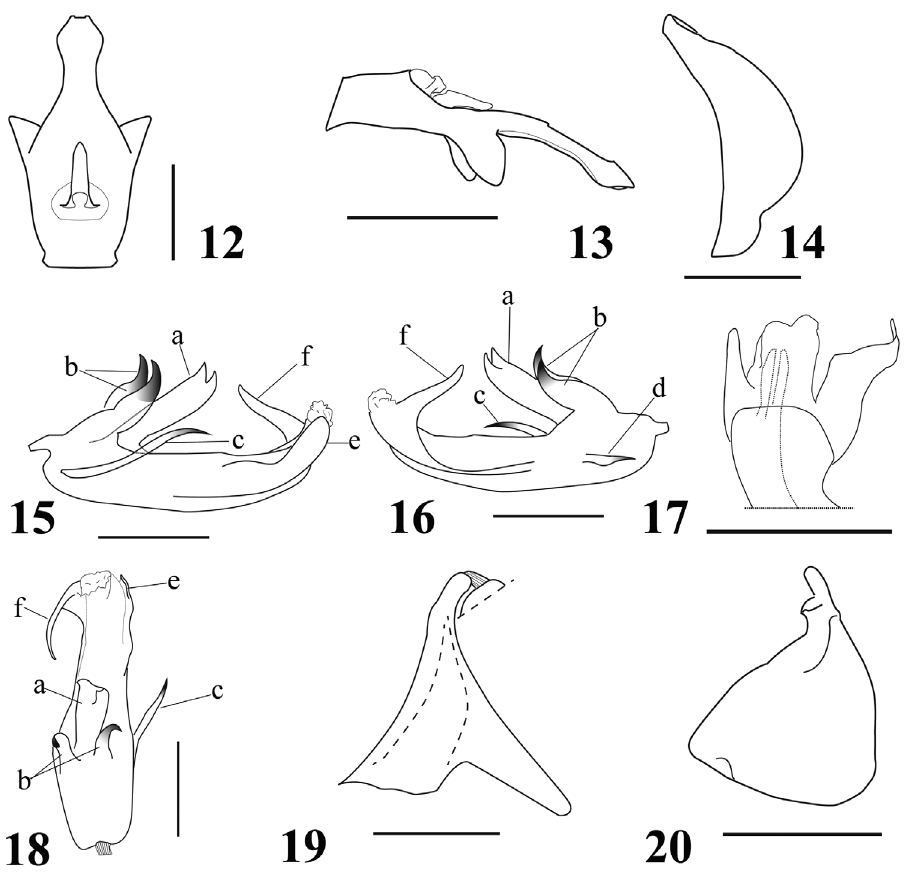
Figures 12–20. E. guangxiensis sp. n. 12 Anal tube (male), in dorsal view 13 Anal tube (male), in lateral view 14 Pygofer (male), in lateral view 15 Penis, in lateral view (left) 16 Penis, in lateral view (right) 17 Penis, in ventral view 18 Penis, in dorsal view 19 Connective, in lateral view 20 Gonostylus, in lateral view. Scale bars: 0.5